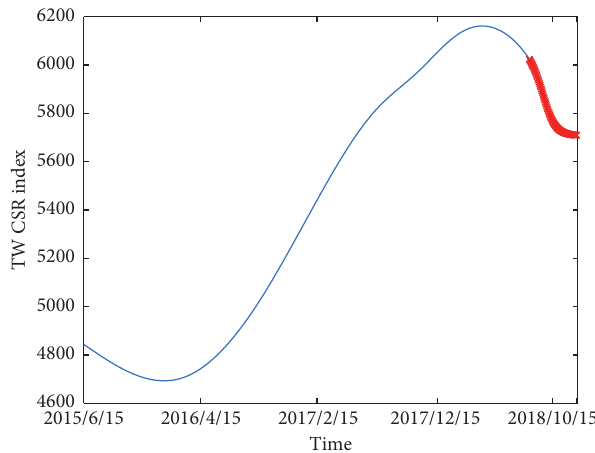
Figure 21: LSTM prediction results for IMF6.